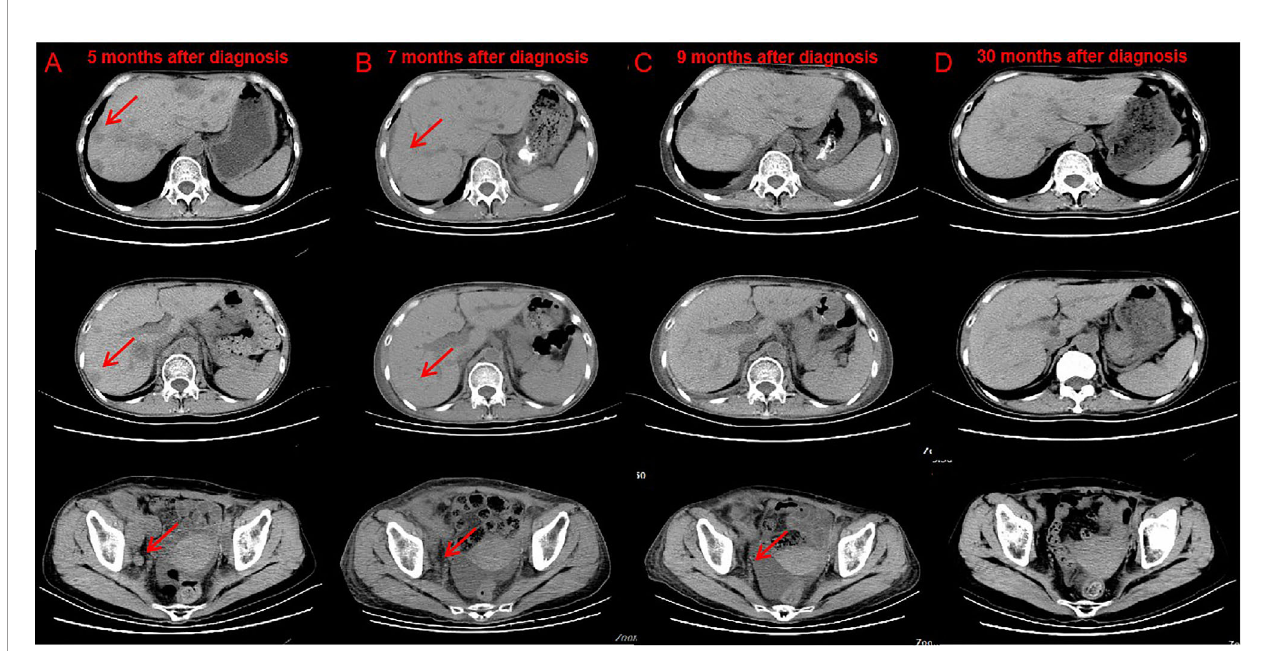
FIGURE 2 | CT after nivolumab indicated tumor response. Compare CT of April 18, 2019 (B) with February 20, 2019 (A) Bladder cancer with liver, abdominal cavity, retroperitoneal, pelvic, bilateral inguinal lymph node metastasis, part of the liver lesions and lymph nodes shrink. CT of June 3, 2019 (C) and March 2, 2021 (D) showed no lesions were found in the liver, abdominal cavity, retroperitoneal, pelvic.